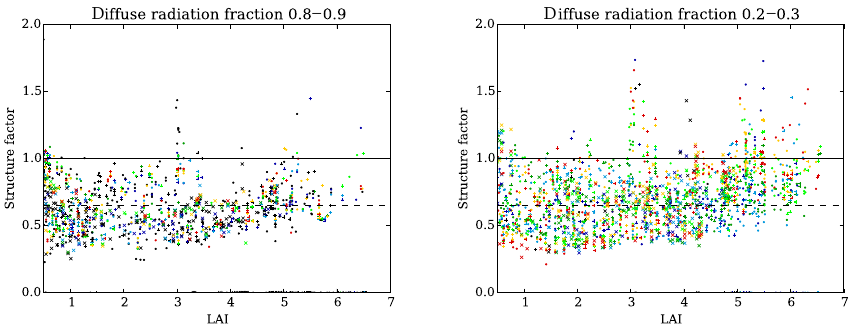
Figure 14. Derived value of the clumping factor a against LAI for each combination of FAPAR and observed diffuse radiation fraction. Dots, vertical crosses (+) and diagonal crosses (x) use US-Ne1, US-Ne2 and US-Ne3 LAI observations respectively, and all data are between emergence (DVI = 0) and flowering (DVI = 1). Colours show the cosine for the zenith angle (for legend, see Fig. 13). Solid black line indicates a = 1 and dashed black line indicates a = 0 . 65.